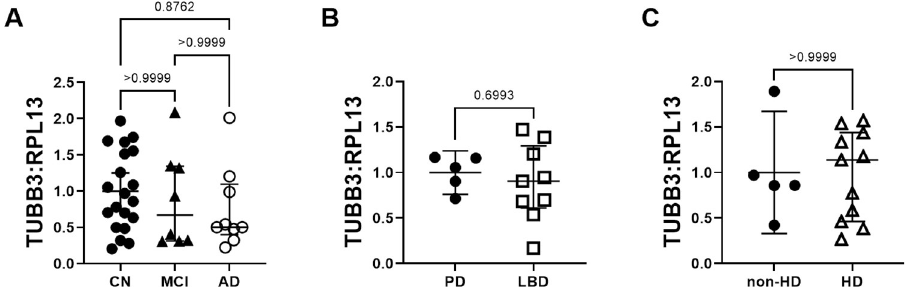
Fig 6. β III-tubulin relative mRNA expression levels in neurological disease. β III-tubulin mRNA levels do not differ in AD and MCI (A), LBD (B) or HD (C) compared to controls.